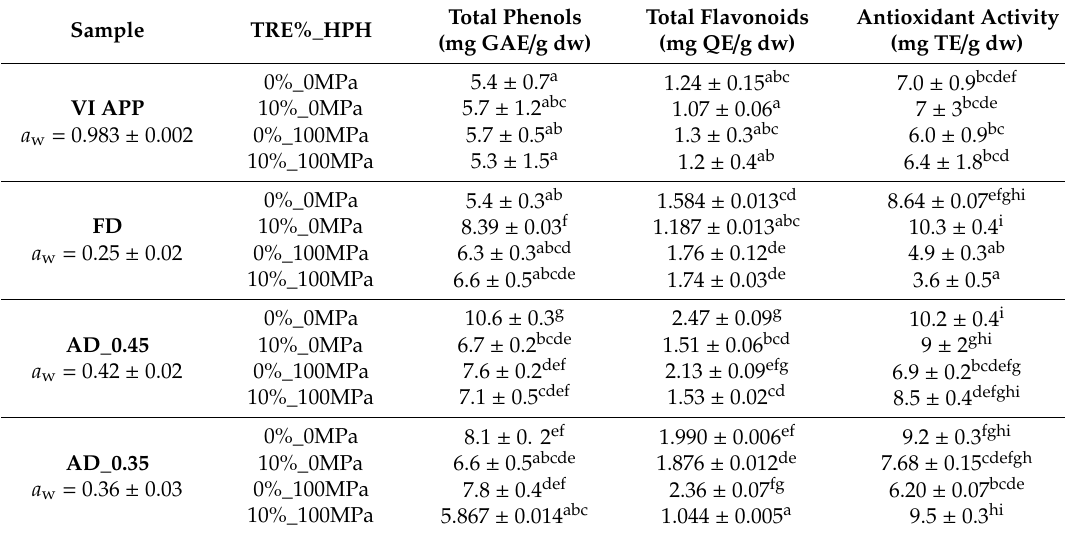
Table 2. Antioxidant properties of apple samples after each stage of the snack manufacturing process. VI APP stands for vacuum impregnated apples, FD stands for freeze-dried apples, AD_0.45 stands